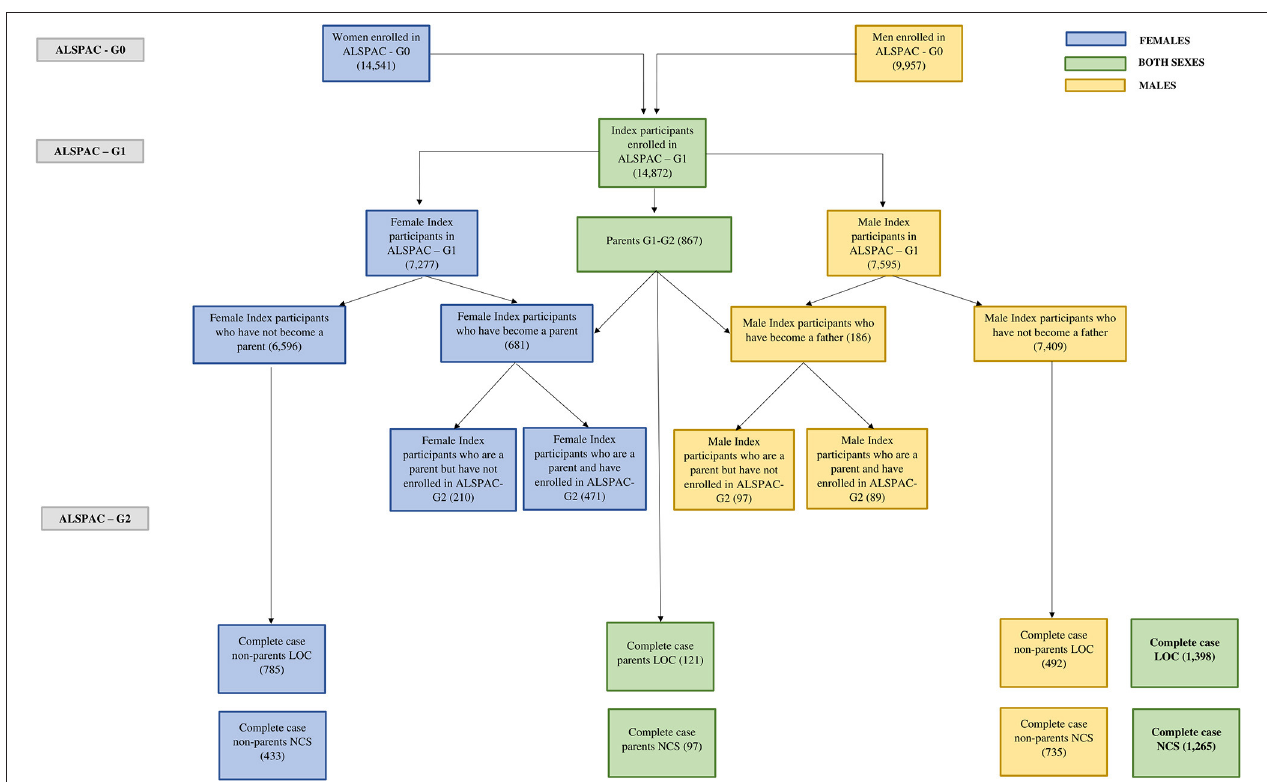
FIGURE 1 | ALSPAC Flow. The present figure illustrates the sample included in our analyses (bottom rows of the graph) for both the LOC and NCS models. It describes the flow from the original mothers (ALSPAC-G0) recruited in the study up to the participants who had all the information needed to be eligible for our analysis. In the center of the figure we also illustrate how many ALSPAC-G1 participants are known to have become parents and how many have enrolled their children into the next ALSPAC generation (ALSPAC-G2). Different colors are used to distinguish between males and females. The legend of the colors is embedded in the